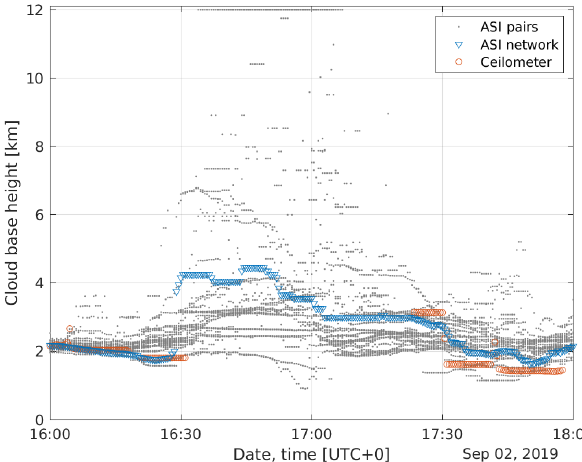
Figure B1. Detailed view of the CBH measured by ASI pairs (gray dots), by the ASI network (blue triangles) and ceilometer (red cir- cles) during a period with low sky coverage. Around 17:00, ap- proaching clouds are viewed close to the horizon by all